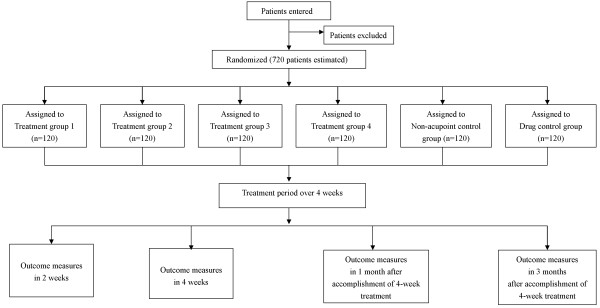
Trial flow chart.